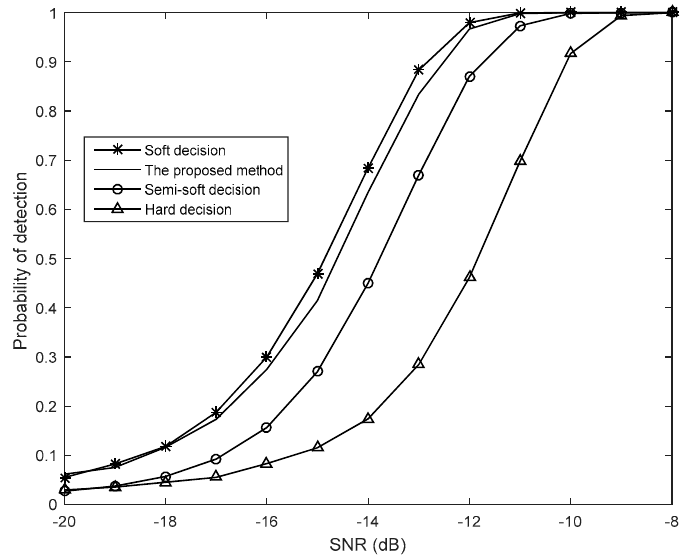
Figure 4. Comparisons of the probability of detection P d ( M = 10, N = 1000, P f = 0.01).